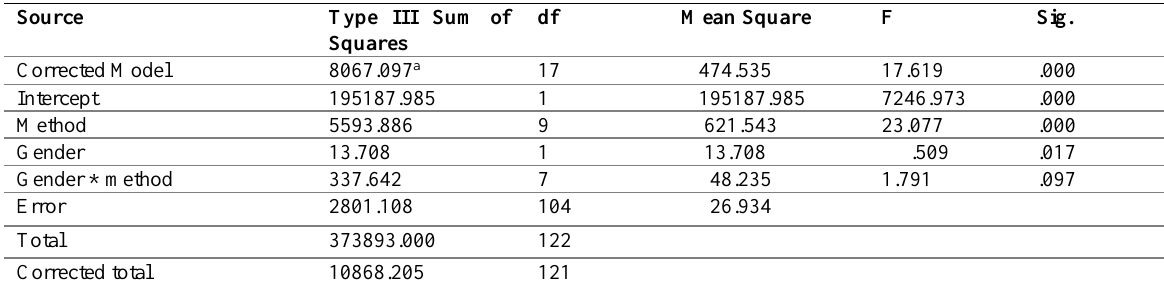
Table 3 shows F-calculated values for three effects: treatment (CBL and ABL), gender and interaction of treatment and gender